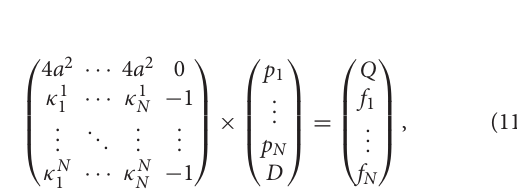
FIGURE 4 | Contact pressure distribution within central section of indenter and plane Oy. h ∗ = 0.03,0.1, ∞ (curves 1-3 respectively), c = 5, ν = 0.3, Q ∗ = 0.1, V ∗ = 0.05.